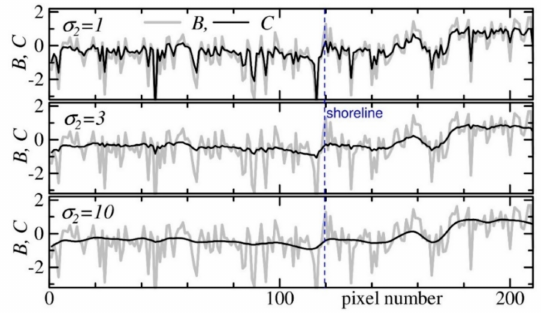
Figure 4. Distribution of B (thick grey lines) and C (thin black lines) along the line L shown in Figure 2e. The top, middle, and the bottom panels show the same B but different C with σ 2 = 1, 3, and 10,